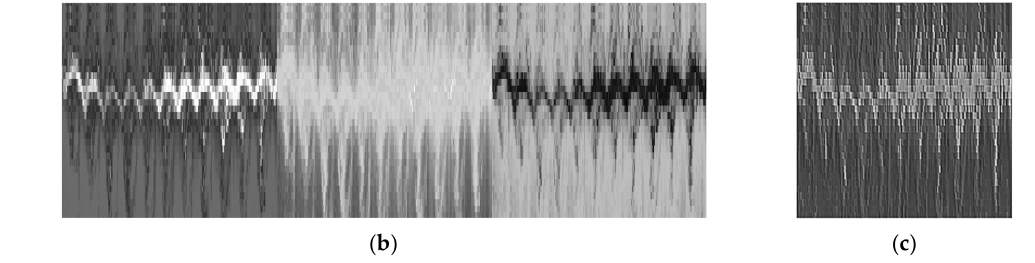
Figure 11. Features learned from the gait biometric: ( a ) a sample input image, which is an output of the gait signal processing pipeline; ( b ) the features extracted from the first convolutional layer; ( c ) the strongest feature in the third convolutional layer. White pixels represent strong positive activations and black pixels represent strong negative activations.